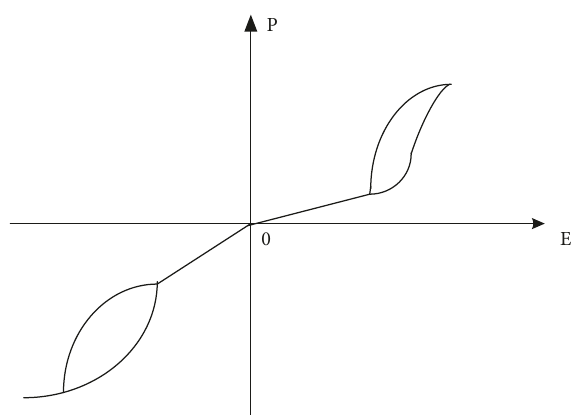
Figure 1: Synthetic frame diagram of crops.